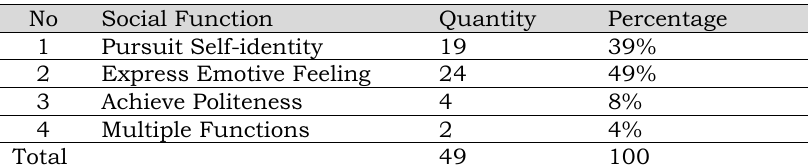
Table 2. Slang word social